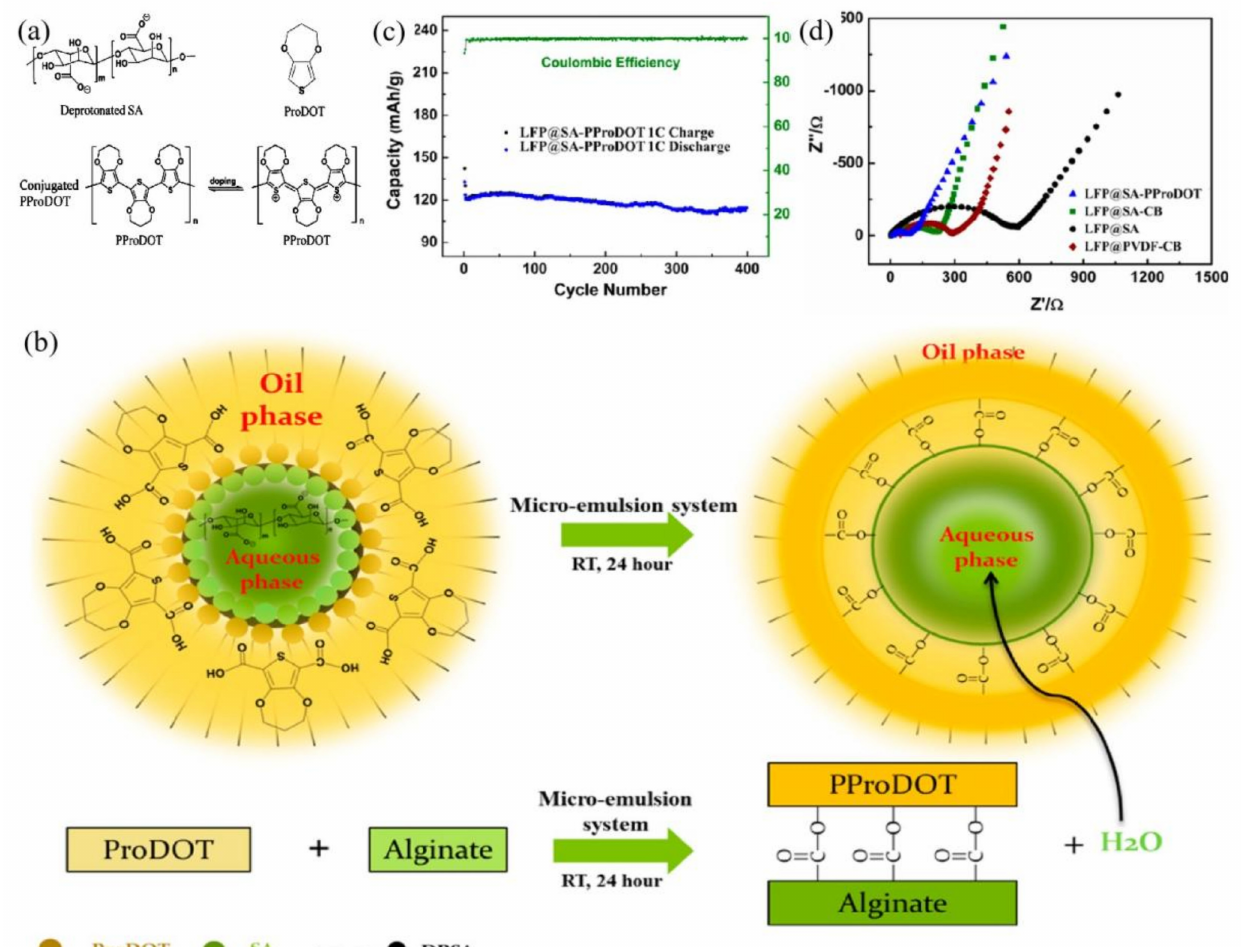
Figure 5. ( a ) Chemical structure of deprotonated SA, ProDOT, and PProDOT. ( b ) Schematic design of the microemulsion system for synthesis of SA-PProDOT polymer. ( c ) Long-term performance of LFP electrodes binder based on SA-PProDOT (LFP:binder = 8:2) binder. ( d ) EIS spectra of the LFP@SA-PProDOT, LFP@SA-CB, LFP@SA, and LFP@PVDF-CB samples between 0.1 Hz and 100 kHz. Reprinted with permission from ref. [78]. Copyright 2015 the American Chemical